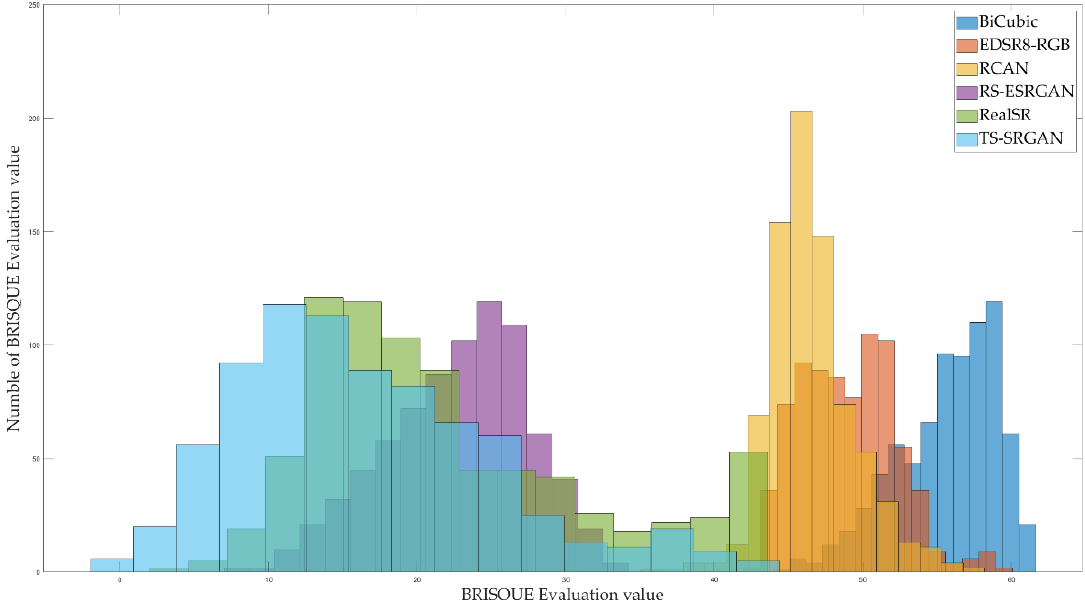
Figure 12. Distribution of evaluation values of NR-IQA metric BRISQUE.